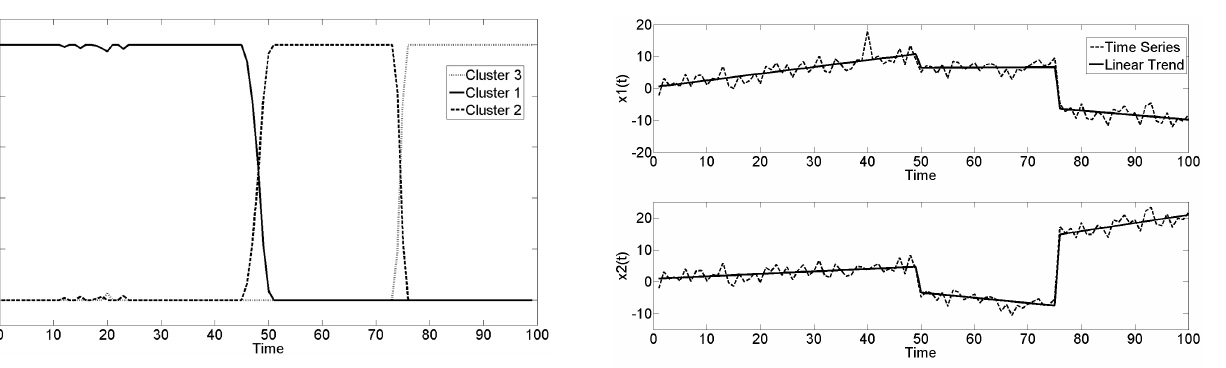
Figure 3. Detected clusters and linear trends for synthetic data when K = 3 and δ = 1. Results show good clustering.